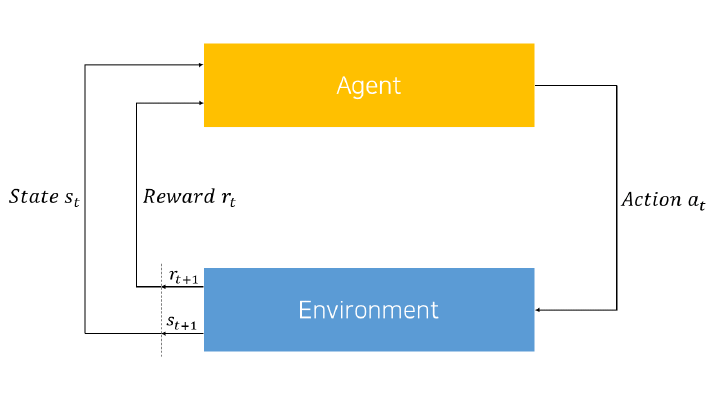
Figure 1. Agent–environment